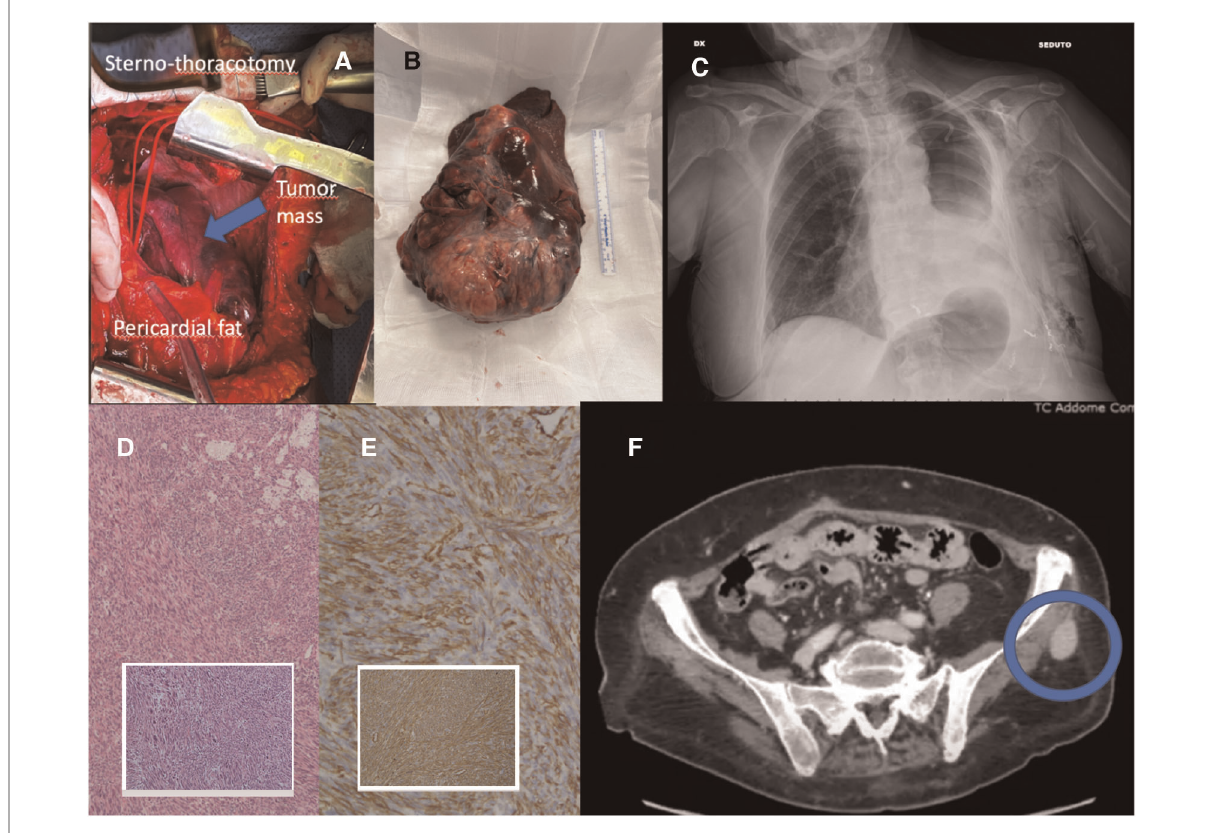
FIGURE 2 ( A ) Intraoperative view of hemiclamshell incision; ( B ) left lung en-bloc with mass; ( C ) postoperative chest x-ray; ( D ) hematoxylin-eosin, (10×, 4×) leiomyosarcoma of the lung; ( E ) immunohistochemistry, smooth muscle actin and muscle-speci fi c actin (10×); ( F ) CT scan showing left gluteal